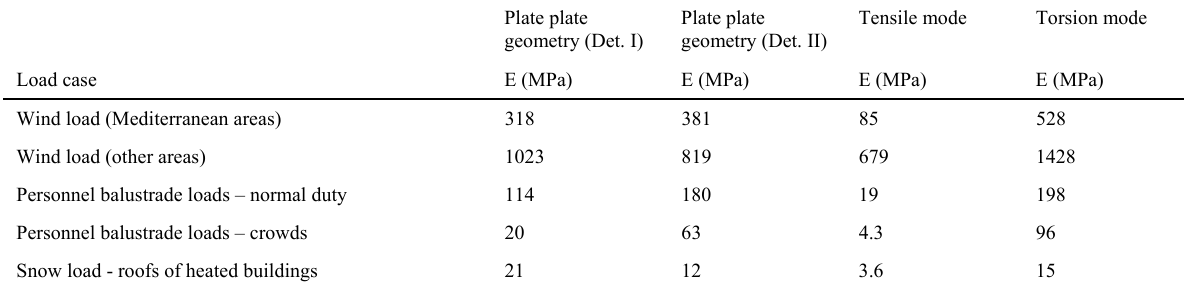
Table 6: Comparison of Saflex ® DG41 interlayer using different deformation modes Plate plate geometry (Det.